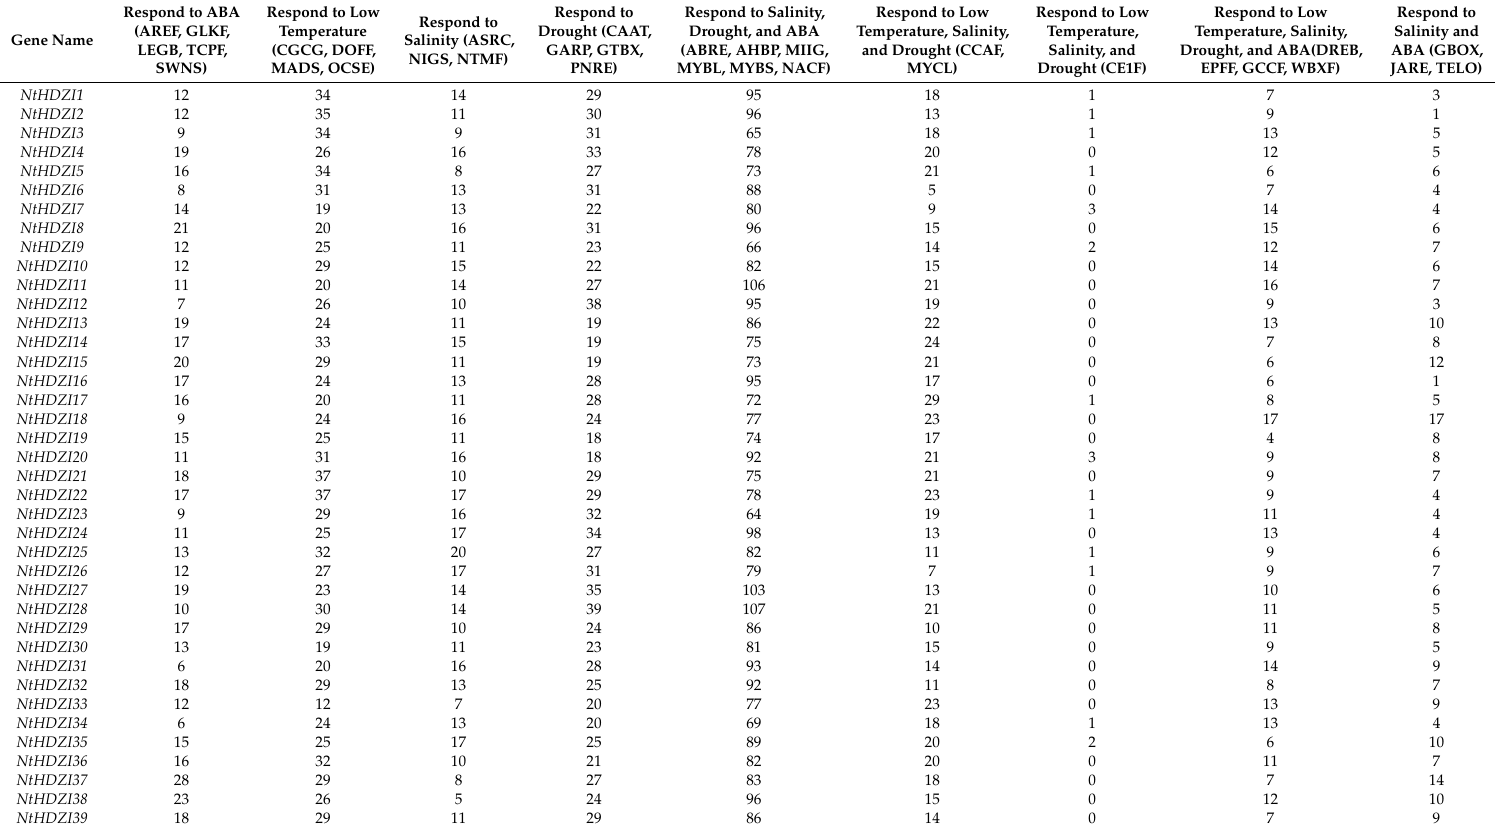
Table 2. The number of stress-responsive cis-acting elements in the promoter region of each NtHDZI